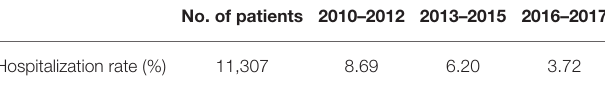
TABLE 5 | Results for hospitalization rate.